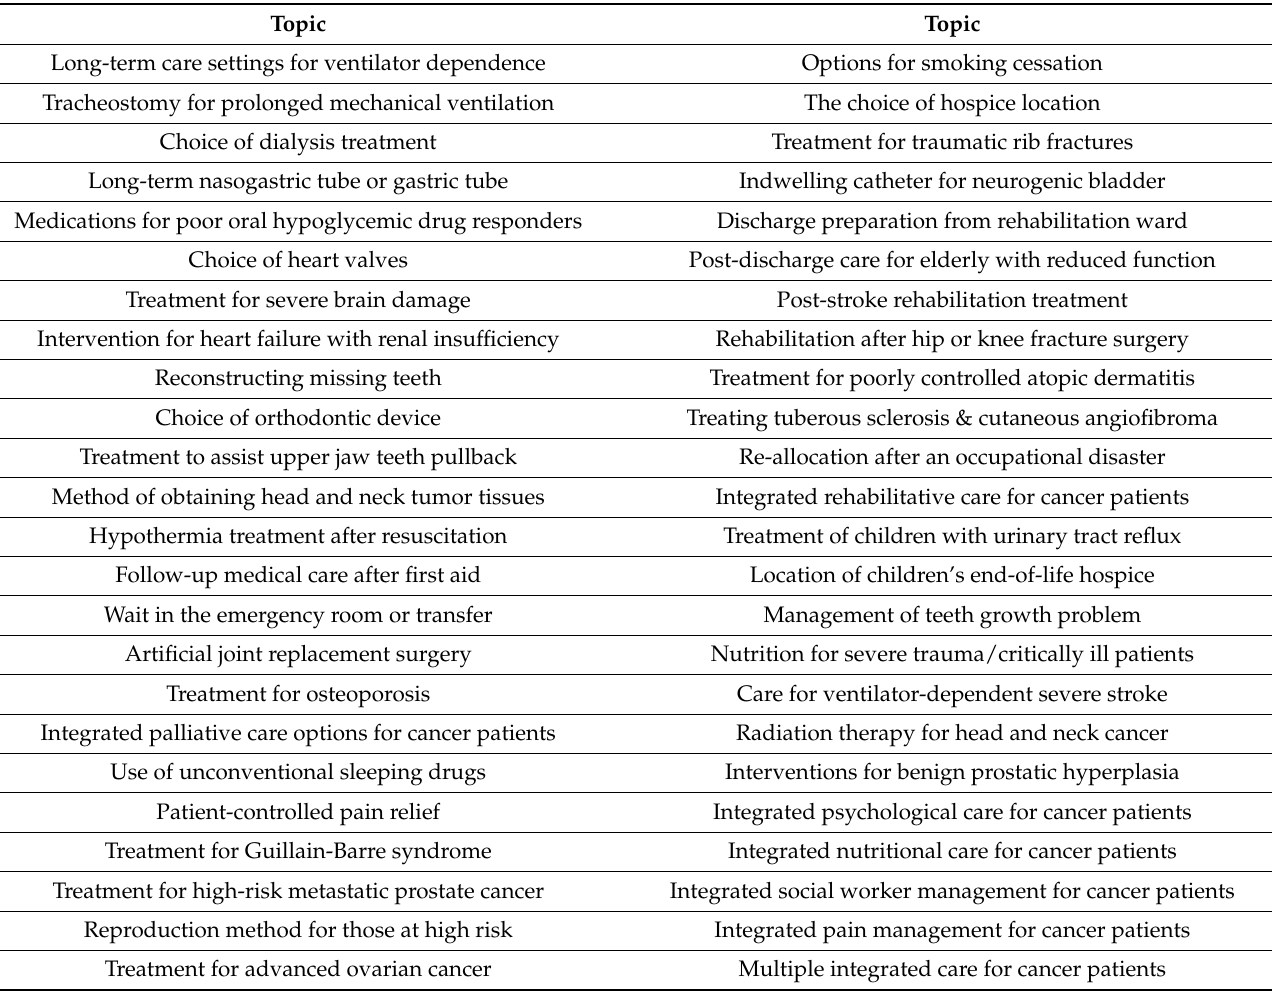
Table 1. Topics of SDM developed during the study